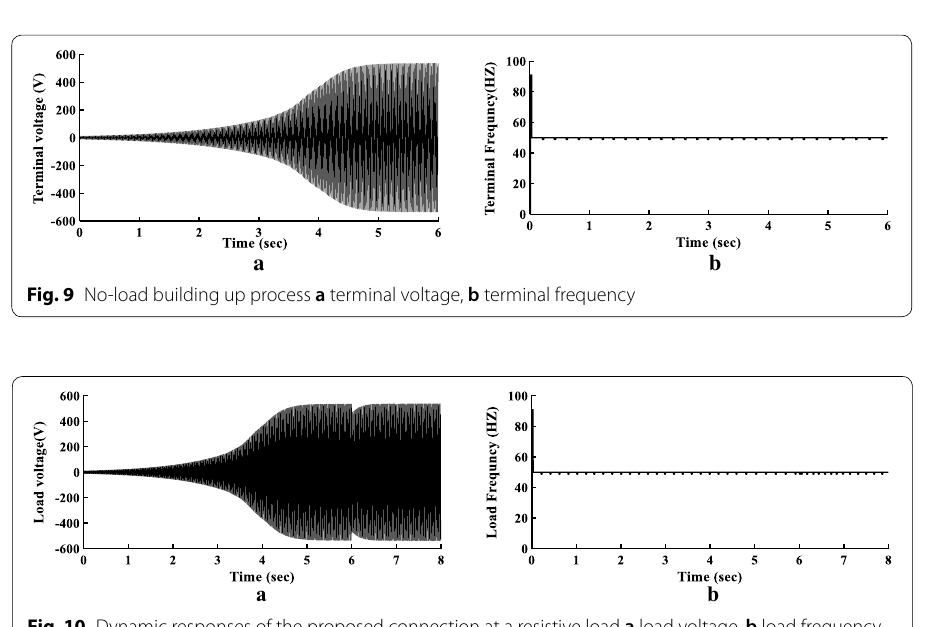
Fig. 10 Dynamic responses of the proposed connection at a resistive load a load voltage, b load